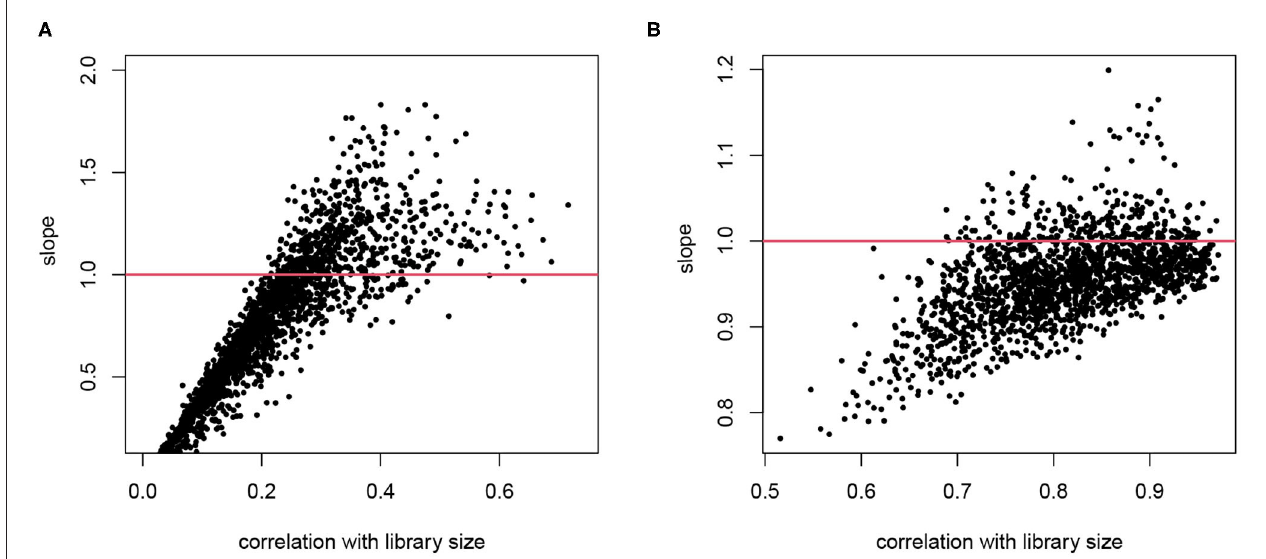
FIGURE 1 | The relationship between counting efficiency with library size. The log transformed counts are regressed on log library size and the slope is plotted against the correlation between the gene counts and the library size. A slope of 1 indicates a linear effect of library size on counting efficiency. (A) Data from T2D study. (B) Data from hESC study. Only genes with average log counts greater than 4 are